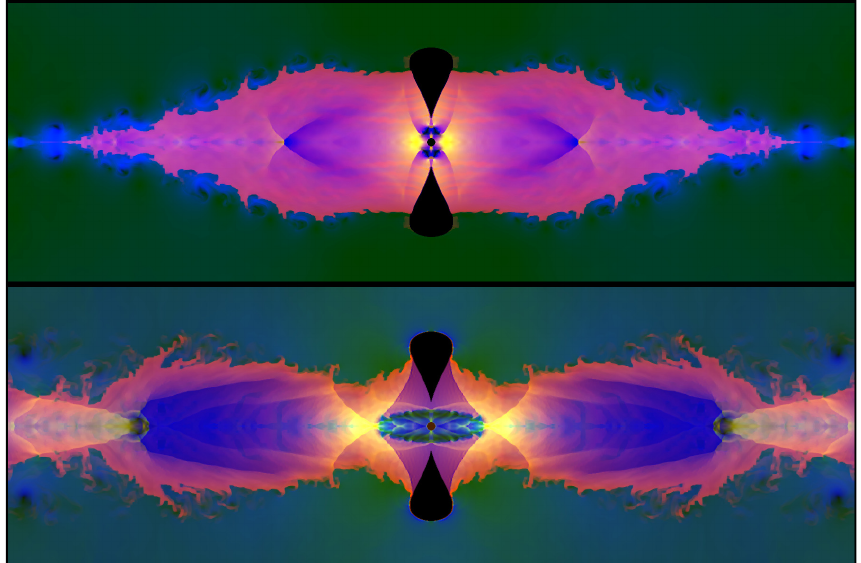
Figure 7. Cross section snapshot of two simulations with identical setup for geometry, boundary conditions, and irradiation. ( Top ): Case A initial conditions in Equation (9), so that all of the stellar energy is turned into the kinetic energy of the evaporation. ( Bottom ): Case B initial conditions in Equation (8), wherein the energy available is divided between kinetic and thermal